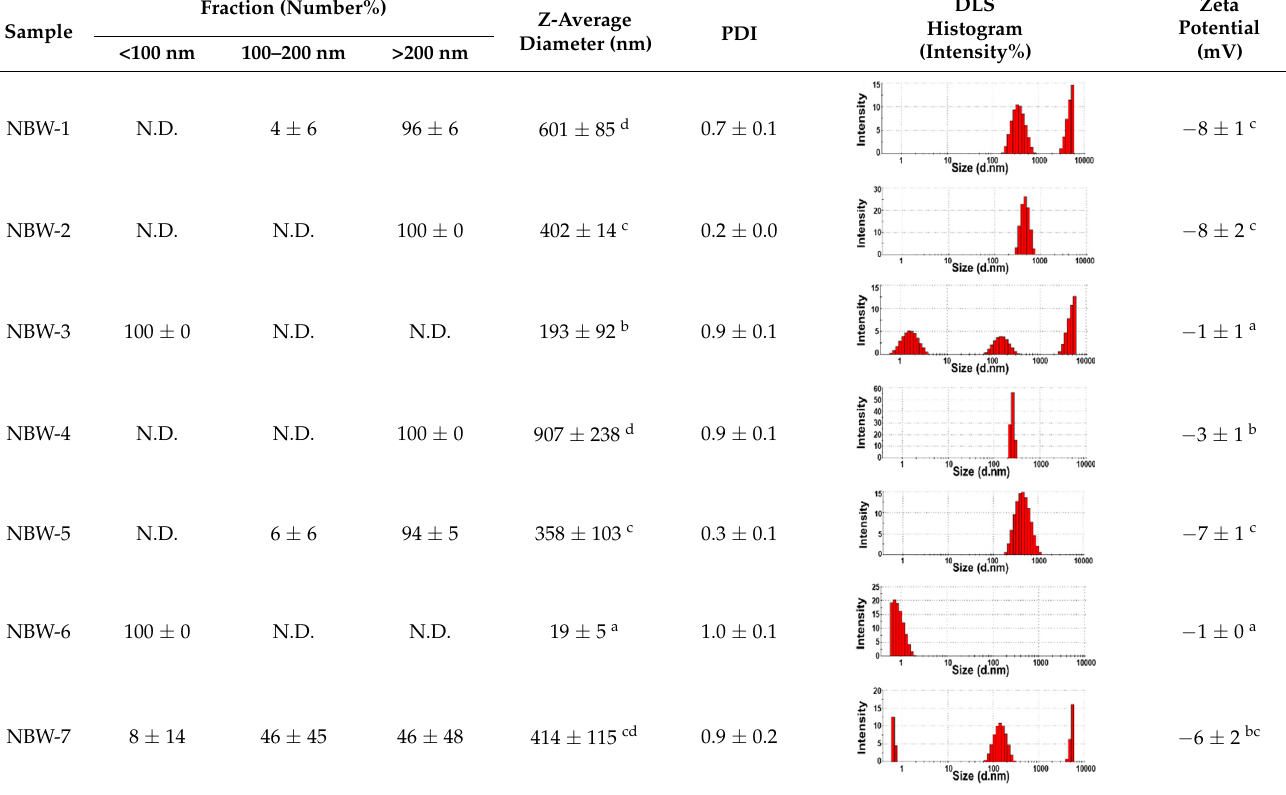
Table 3. Particle fractions, hydrodynamic diameters, and surface charges of nanobubbles in NBWs after storage for 6 months 1 .